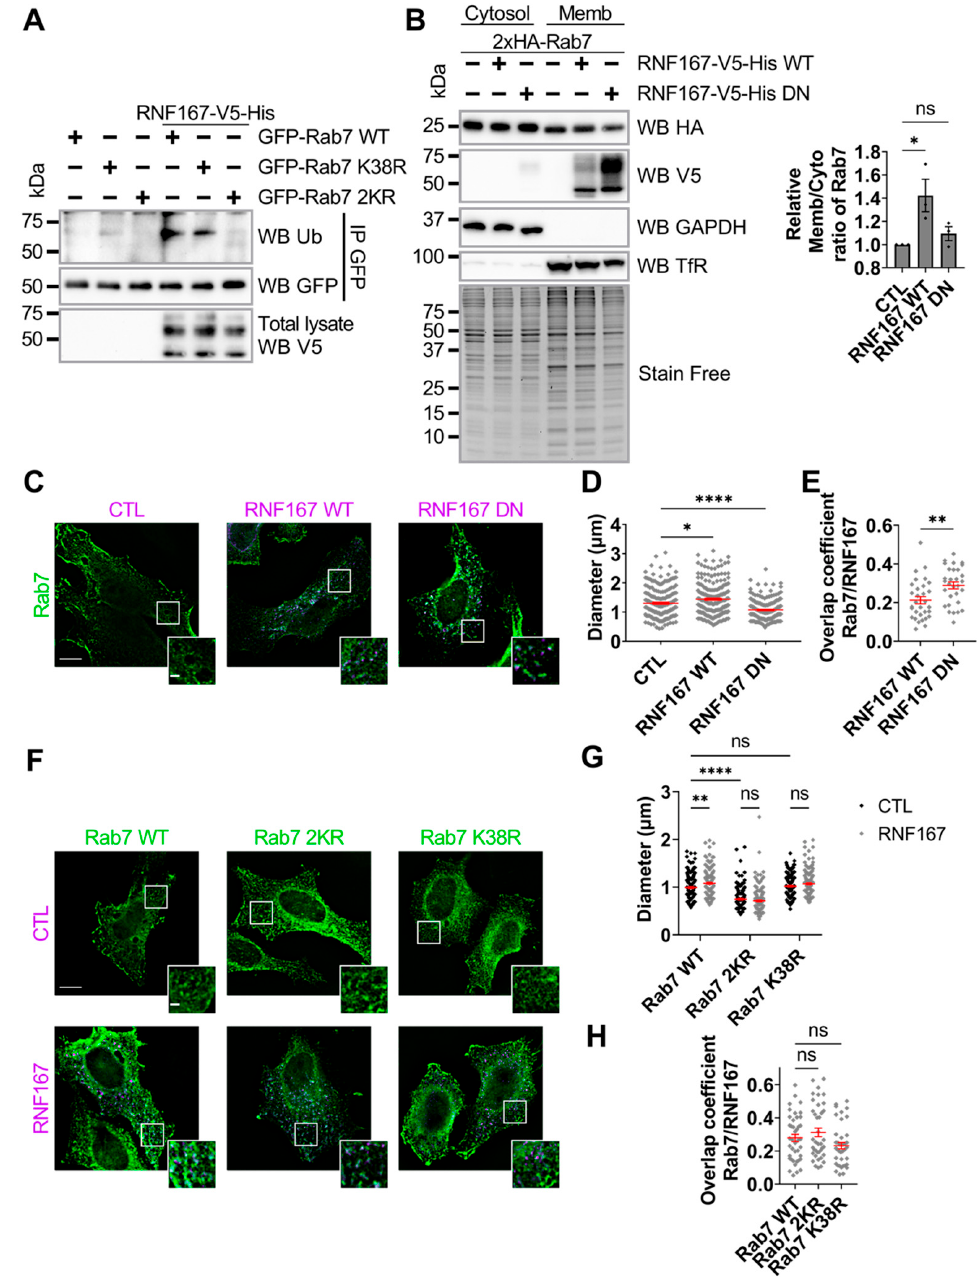
Figure 2. RNF167 promotes Rab7 membrane localization . ( A ) Lysine substitutions in Rab7 protein reduce RNF167-mediated ubiquitination. HEK293T cells were transfected with the respective plasmids encoding the indicated proteins indicated in panel ( A ). Cells were lysed before immunopurification with a GFP antibody. Rab7 variant 2KR represents a combination of both K191R and K194R. Blots are representative results of two independent experiments. ( B ) Subcellular fractionation to separate cell membrane from the cytosol from HEK293T cells transfected with plasmids encoding the indicated proteins. Fractions were immunoblotted with antibodies against HA (Rab7) and V5 (RNF167), GAPDH (cytosol marker), and Transferrin receptor (TfR, membrane marker). The stain- free signal was used as a loading control and used for normalization. The blots shown are repre- sentative results from three separate experiments. Non-parametric one-way ANOVA with Kruskal– Wallis post-test was used, ns = non-significant, *, p = 0.0459. ( C – E ) Quantitative analysis of vesicle diameter and overlap in HeLa cells expressing Rab7 and RNF167. HeLa cells were transfected to produce the indicated proteins, fixed, and labeled for immunofluorescence against HA-tag (Rab7, green) and V5-tag (RNF167, purple). ( D ) The sizes of the five largest vesicles corresponding to Rab7